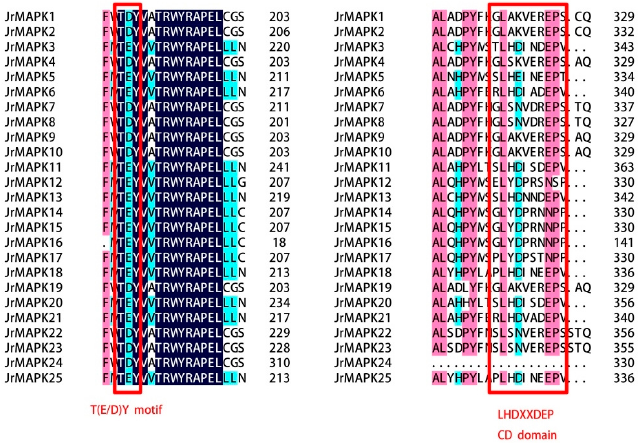
Figure 1. Multiple sequence alignment of proteins in the Mitogen-activated protein kinase (MAPK) gene family in Juglans regia . Dark blue highlighted residues are identical, while other colored highlighted residues are similar in all proteins. Red boxes indicate the TEY/TDY motifs and the conserved docking (CD) domain.